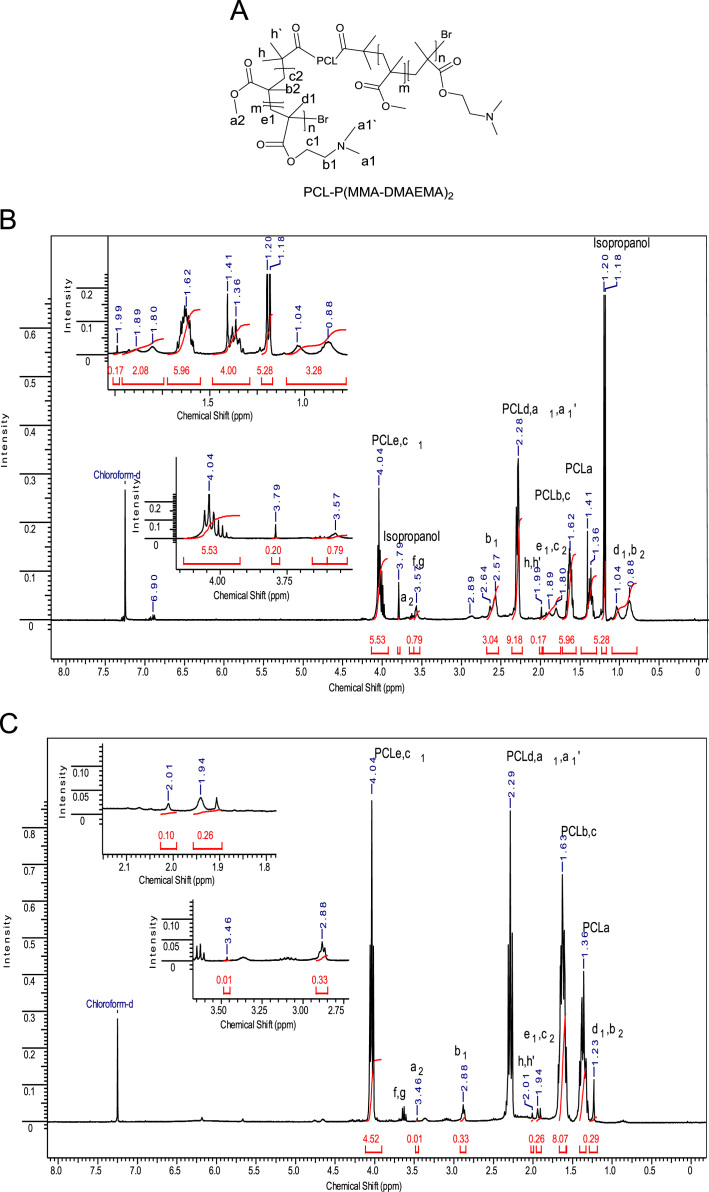
PCL-b-P(DMAEMA-co-MMA)2 structure (A) and 1H NMR (CDCl3, 300 MHz, D) spectra of PCL-b-P(DMAEMA-co-MMA)2 batch 1 (B) and batch 2 (C).